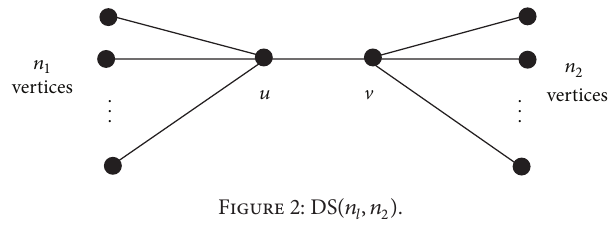
Figure 2: DS (𝑛 𝑙 , 𝑛 2 ) .